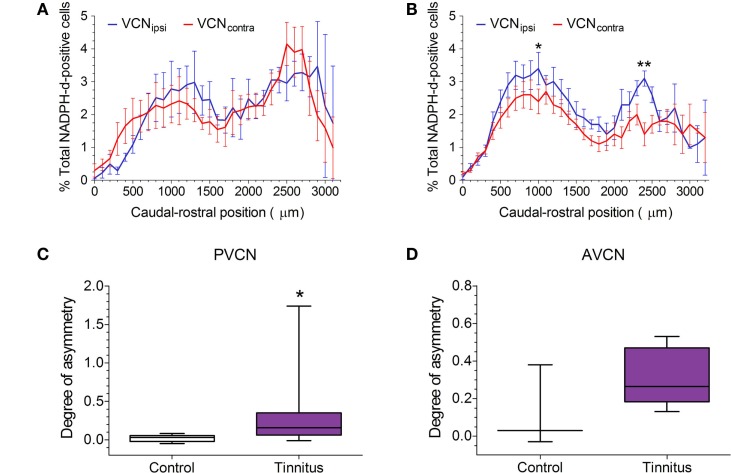
NOS expression in GPs with suspected tinnitus compared with controls. (A) The mean (±SEM) distribution of NADPH-d-stained cells across the VCN in five un-exposed controls, expressed as a percentage of the total population of counted NADPH-d-positive cells, and plotted according to caudal–rostral position. VCNipsi is shown in blue and VCNcontra in red. (B) The mean (±SEM) distribution of NADPH-d-stained cells across the VCN in eight AOE-treated GPs with suspected tinnitus. Data are shown for unilaterally noise-exposed VCNipsi, for which a significantly higher percentage of counted cells was observed, compared with un-exposed VCNcontra (*P < 0.05; **P < 0.01). When data were sub-divided according to the bimodal distribution of NADPH-d in VCN, a significant asymmetry was apparent in (C) PVCN (*P < 0.05) but not (D) AVCN (box and whisker plots show median, interquartile range, and range). Data are expressed as the degree of asymmetry, where values >0 indicate more NADPH-d-positive cells in VCNipsi.